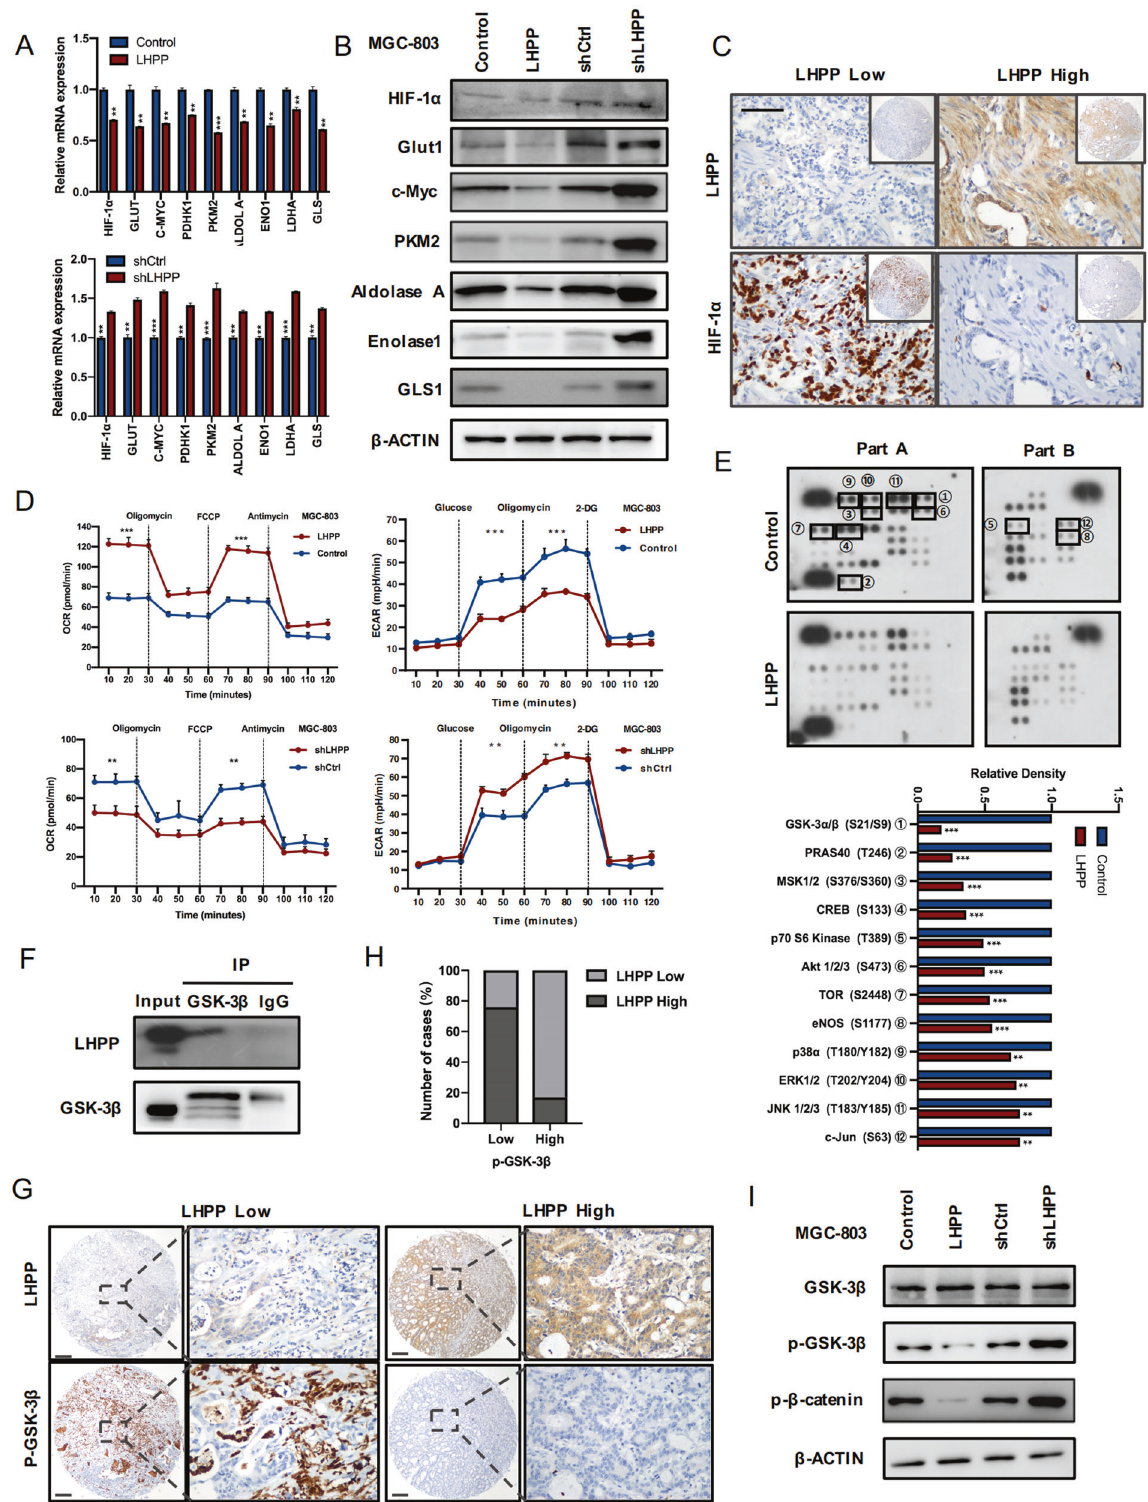
activates the transcription of various glycolytic and glutaminolysis genes. Therefore, we detected the expression levels of glycolysis- related proteins HIF1A, GLUT1, C-MYC, PDHK1, PKM2, ALDOL A, ENO1, LDHA and GLS in MGC-803 cells overexpressing or with knocked down LHPP (Fig. 6A, B). The results revealed that LHPP